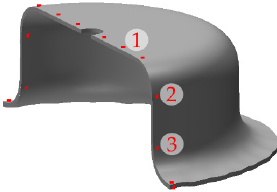
Figure 4. Evaluation points in the manufactured cup after the forming process simulation.